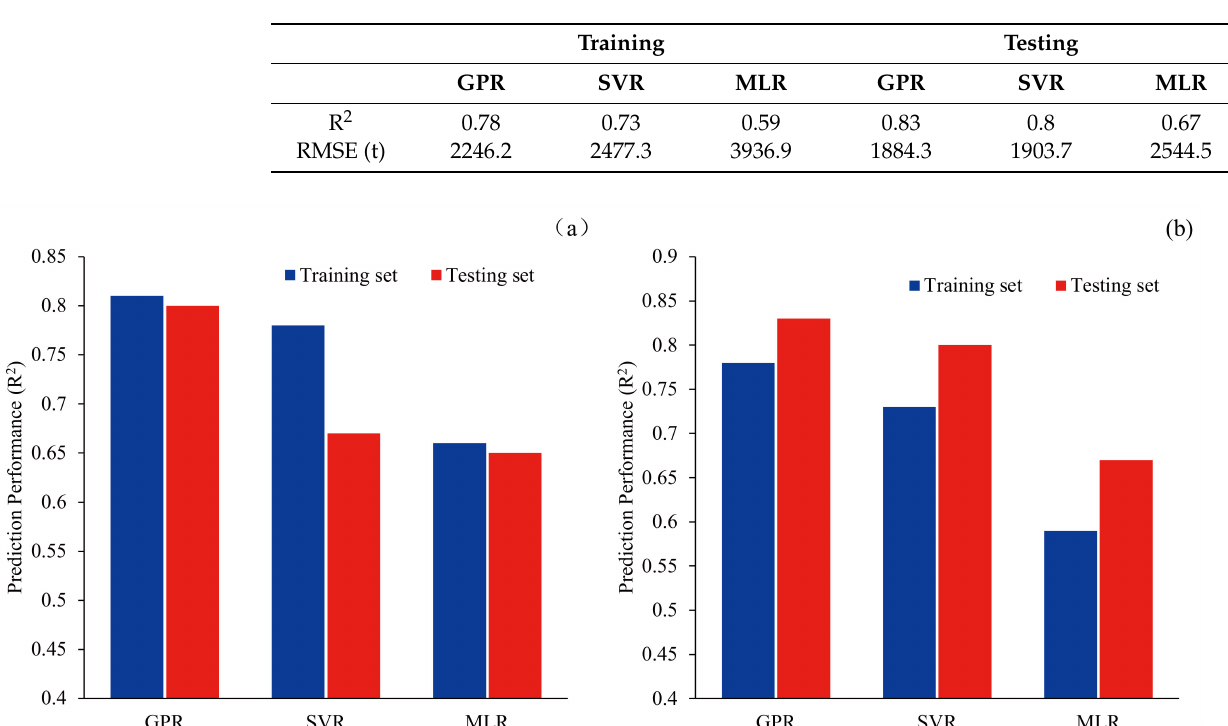
Table 8. Model results for M6COND.